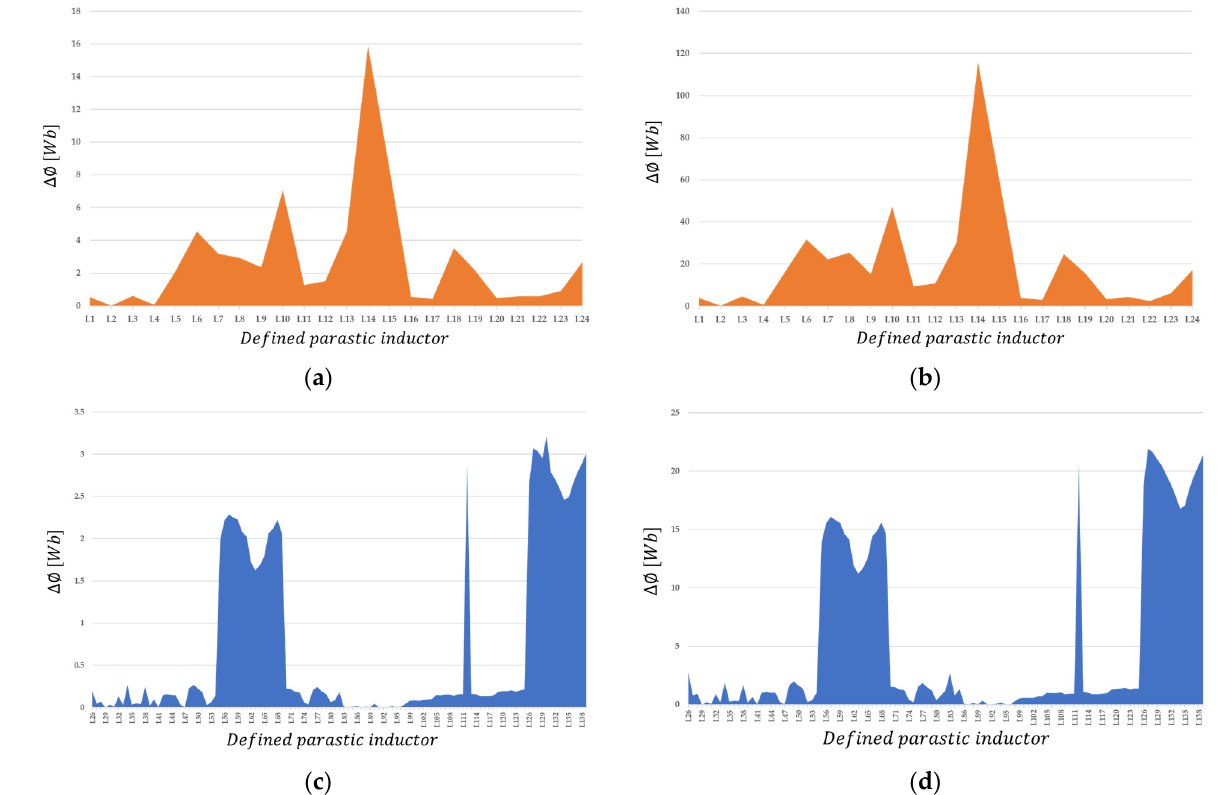
Figure 19. Amount of change in flux analysis. ( a ) Turn-off at top layer. ( b ) Turn-on at top layer. ( c ) Turn-off at bottom layer. ( d ) Turn-on at bottom layer.